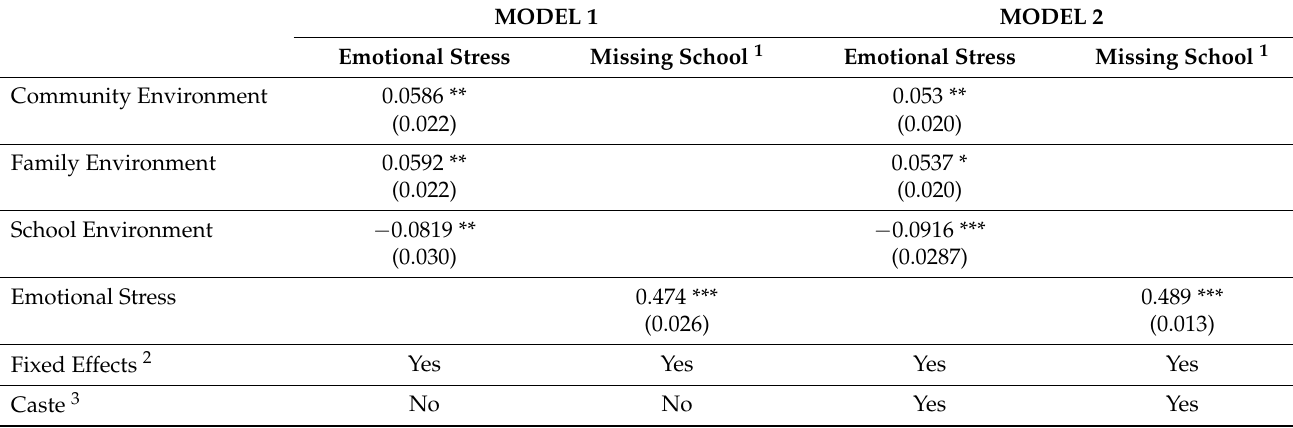
Table 4. Marginal effects of bivariate probit estimation of menstruation-related emotional stress & school